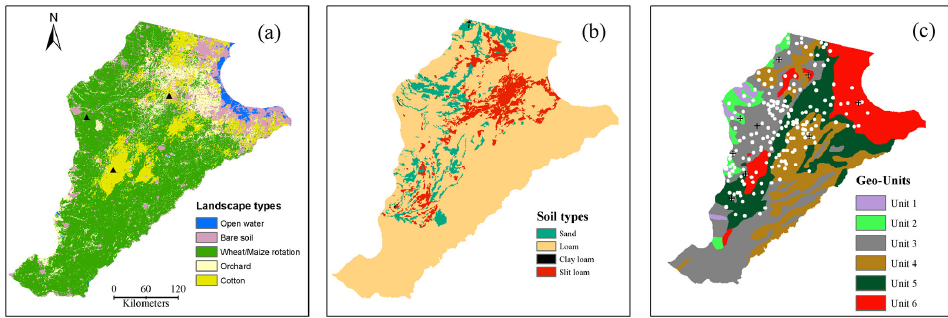
Figure 2. Maps of land cover, soil type and hydrogeological units. ( a ) land cover types based on MODIS NDVI of 2003, the black triangles represent points used for actual ET estimation comparison; ( b ) soil type; ( c ) hydrogeological units. On the map ( c ), the white circle marks for the observation wells used auto-calibration and the cross marks for wells exampled in Figures 3 and